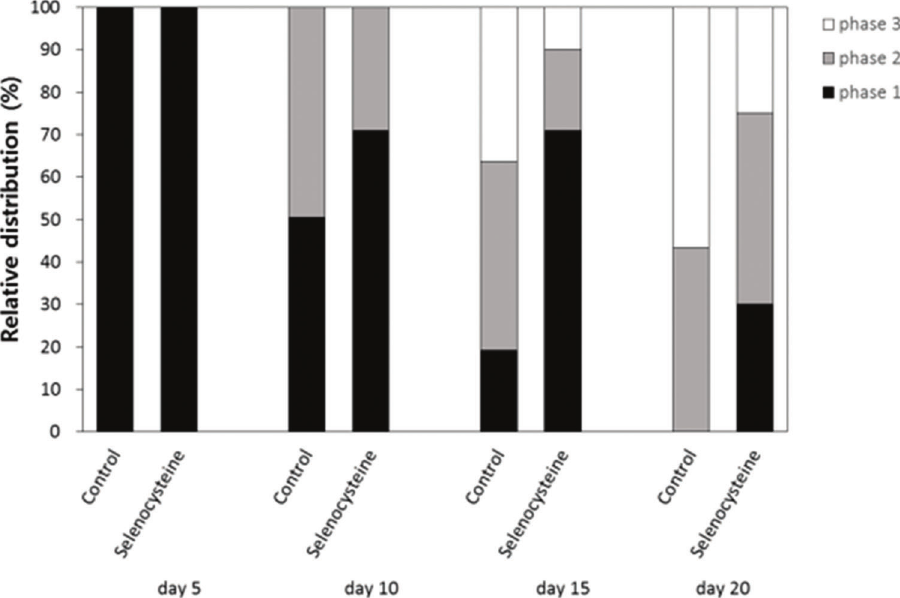
Figure 5 - Delayed age-related decline in motility by selenocysteine. The relative distribution of worms in different locomotive phases was determined on the indicated days for the untreated control and 5 mM selenocysteine-treated animals. ’ phase 1, worms moved spontaneously without any